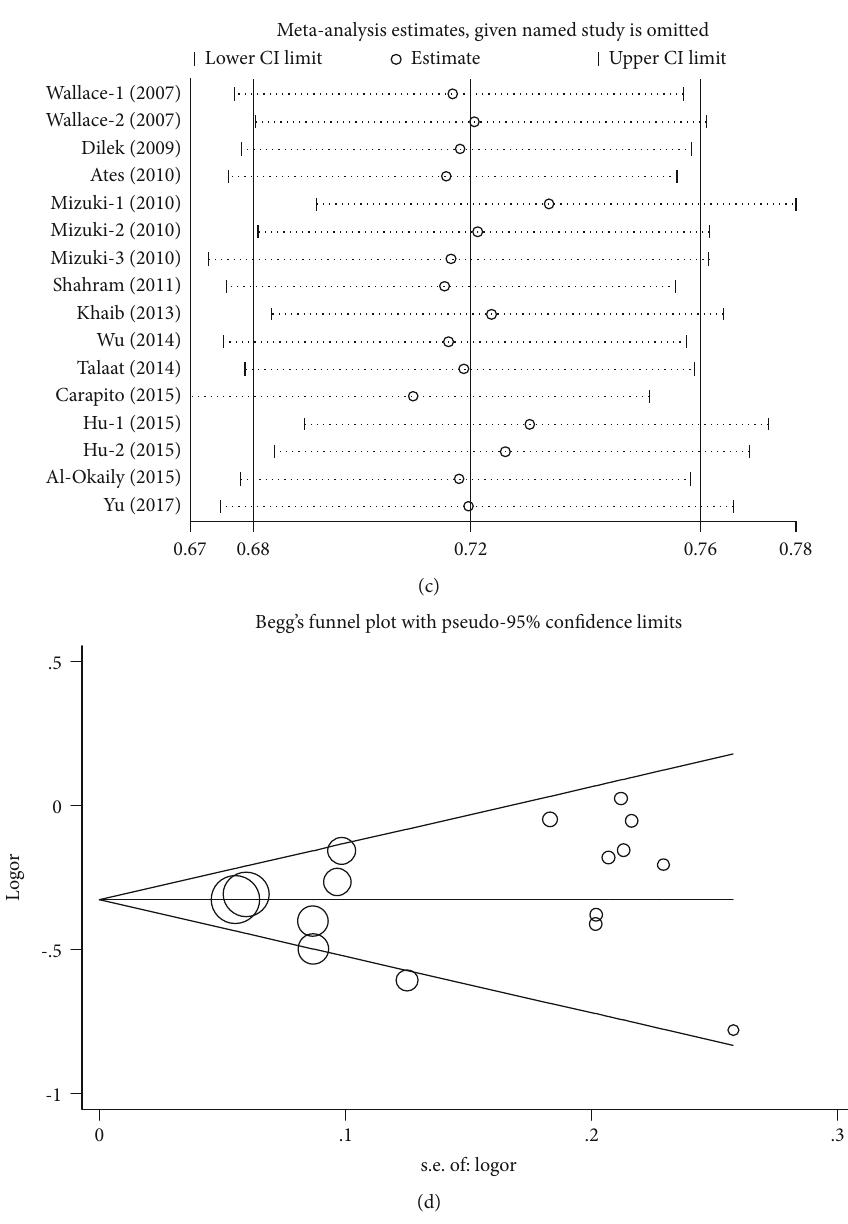
Figure 3: Statistical analysis of the association between IL-10 -819T > C polymorphism and BD risk in the C vs. T model. (a) ORs and 95% CIs; (b) cumulative analysis; (c) sensitivity analysis; (d) publication